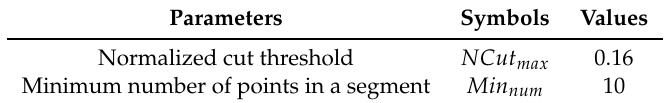
Table 3. Main control parameters for the single tree segmentation using the normalised cut method.